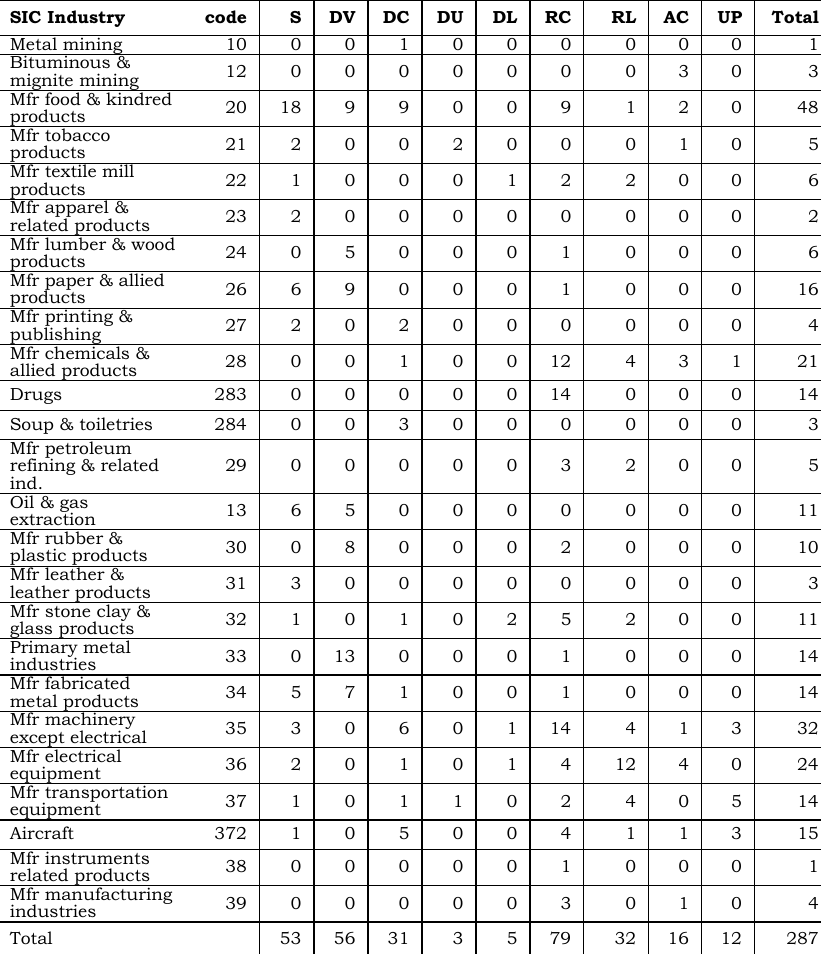
Table 1. Frequency of diversification strategy by industry, 1949 and